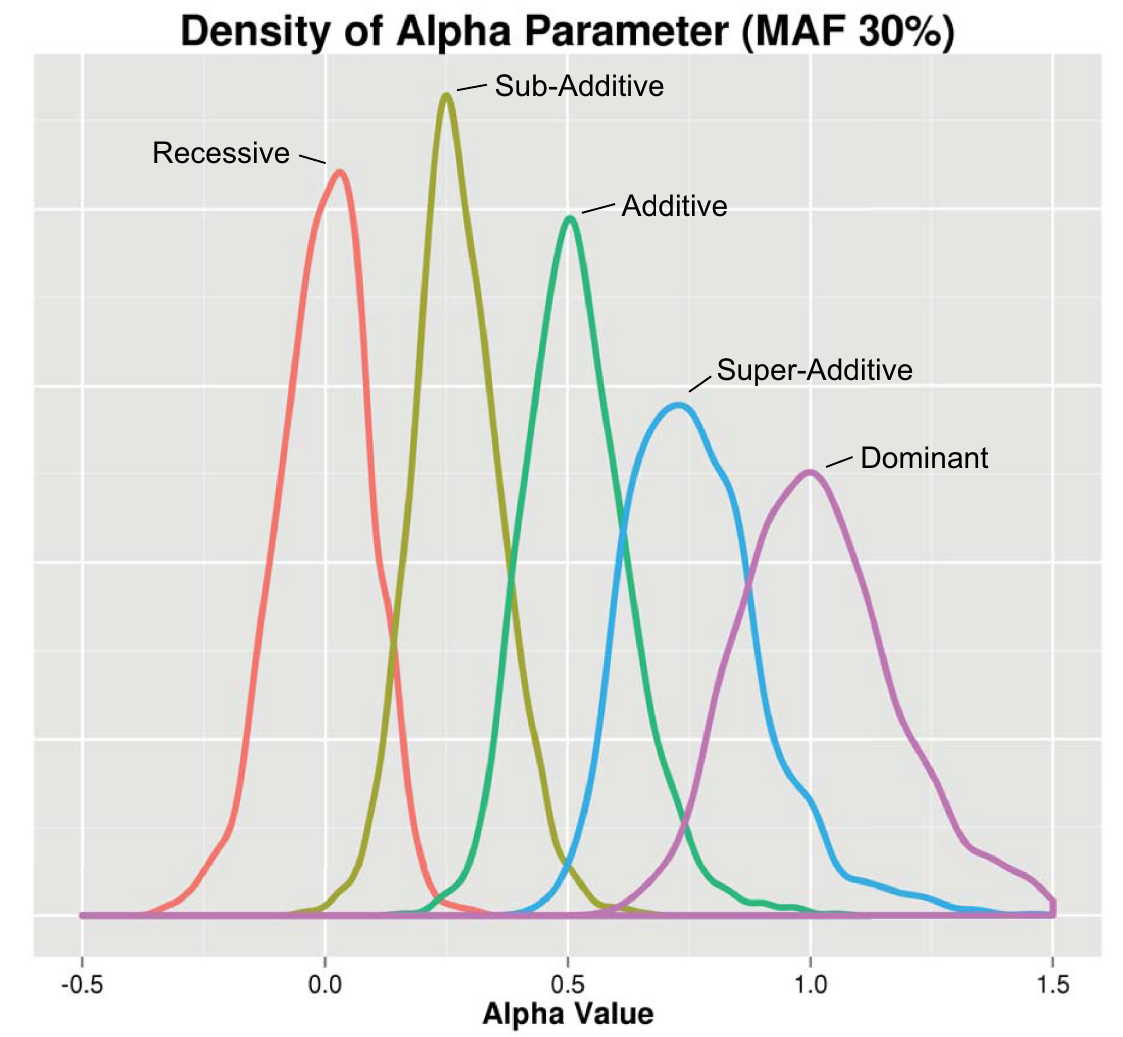
Fig 1. Distribution of the estimated heterozygous action ( α ). Single SNP simulations were performed with five distinct underlying models: recessive (red), sub-additive (yellow), additive (green), super-additive (blue), and dominant (purple). All SNPs shown in this figure were simulated with a 30% MAF. 1,000 datasets for each SNP model were generated and the distribution of the alpha parameter was plotted. Along the x-axis is the EDGE assigned alpha value for simulated SNPs of each genetic model and along the y-axis is the density.